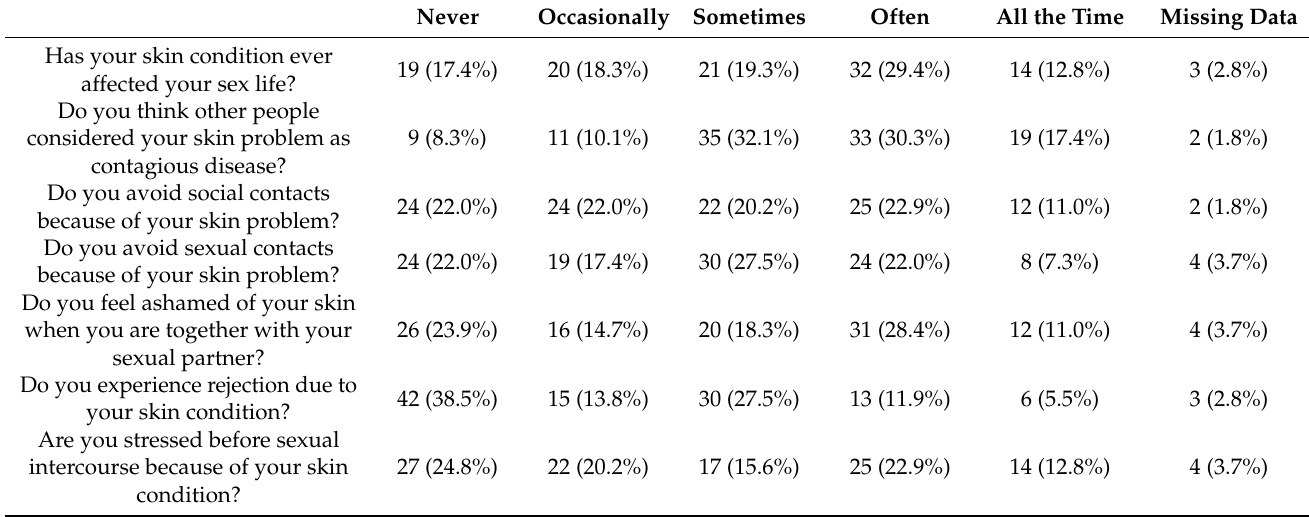
Table 2. Results on psychosocial and emotional problems in men and women with psoriasis related to their sexual life.